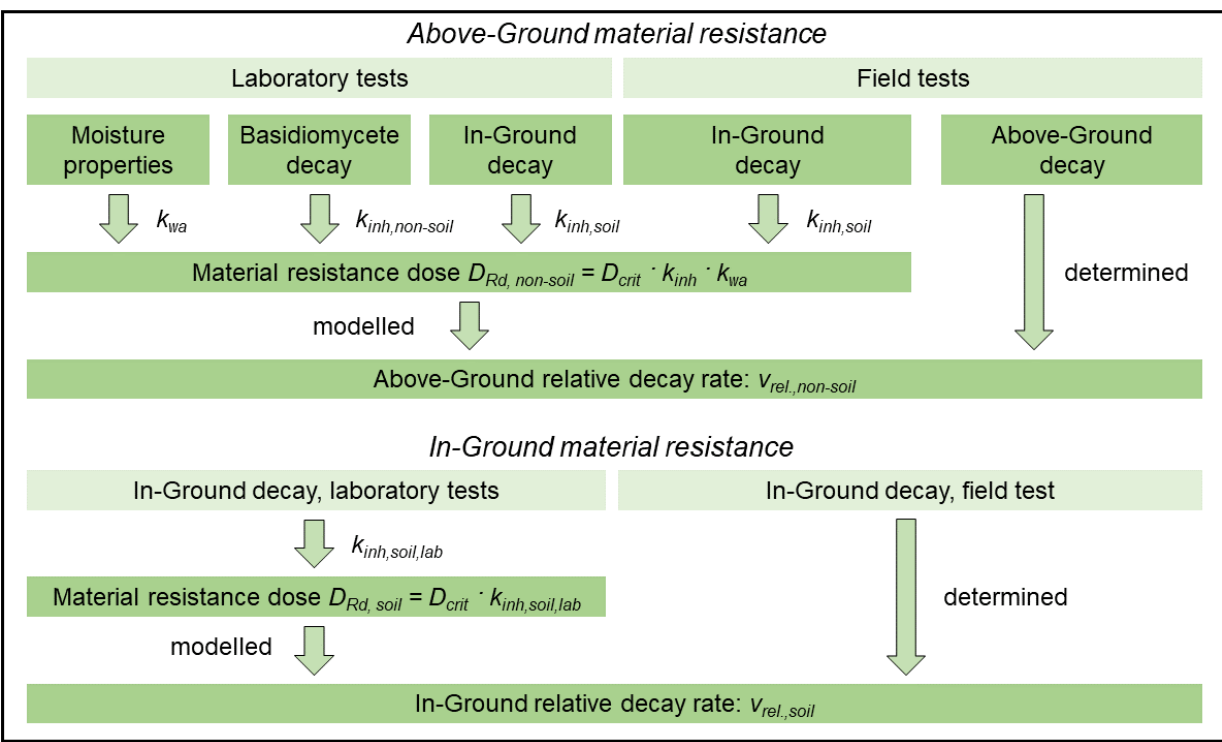
Figure 1. General procedure for determining and modelling relative decay rates, v rel. , for in-ground and above-ground exposure conditions. A more detailed edcsription of the different steps is provided in Part 1 and 2 of this publication